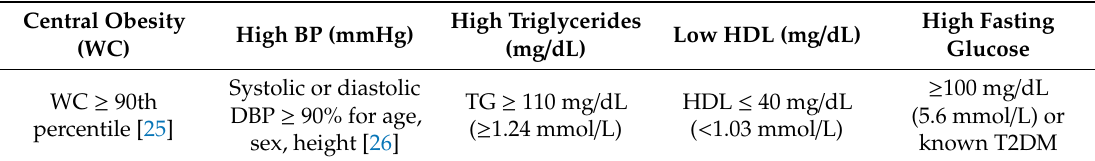
Table 1. Pediatric and adolescent metabolic syndrome (MetS) criteria adapted from the National Cholesterol Education Program Adult Treatment Panel III